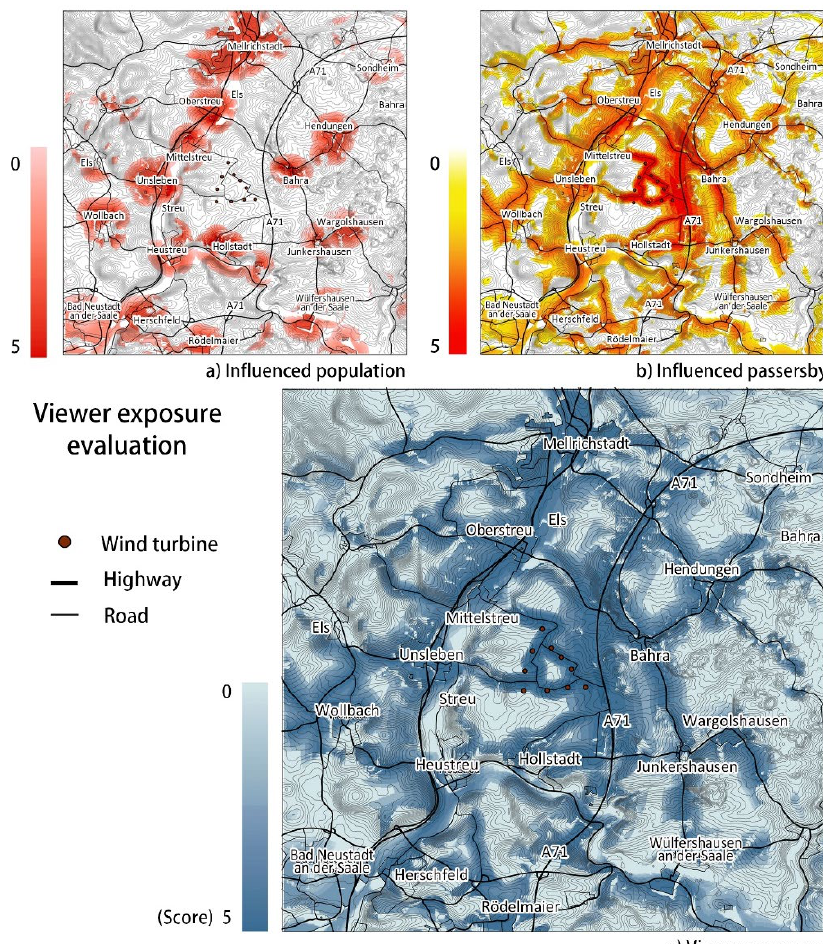
Figure 6. ( a – c ). Results of viewer exposure evaluation. Table 3. Statistical data of the visual impact in different types of land use in the German case.